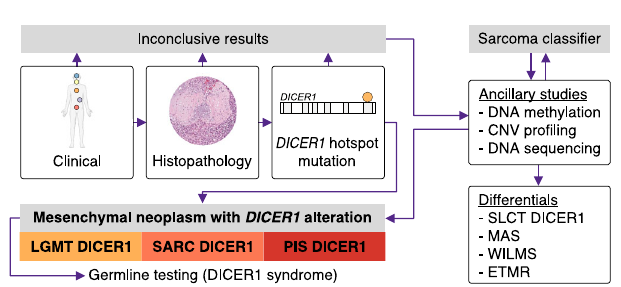
Fig. 7 | Proposed diagnostic algorithm for mesenchymal tumors with DICER1 alteration. Considerationofclinicalfeaturesandhistopathologytogetherwiththe identi fi cationofa DICER1 hotspotpathogenicvariantisusuallysuf fi cienttoclassify DICER1-associated mesenchymal neoplasms. However, in diagnostically challen- ging cases ancillary molecular studies may aid tumor classi fi cation. Diagnosis of a mesenchymal tumor with DICER1 alteration should always promt germline testing for DICER1